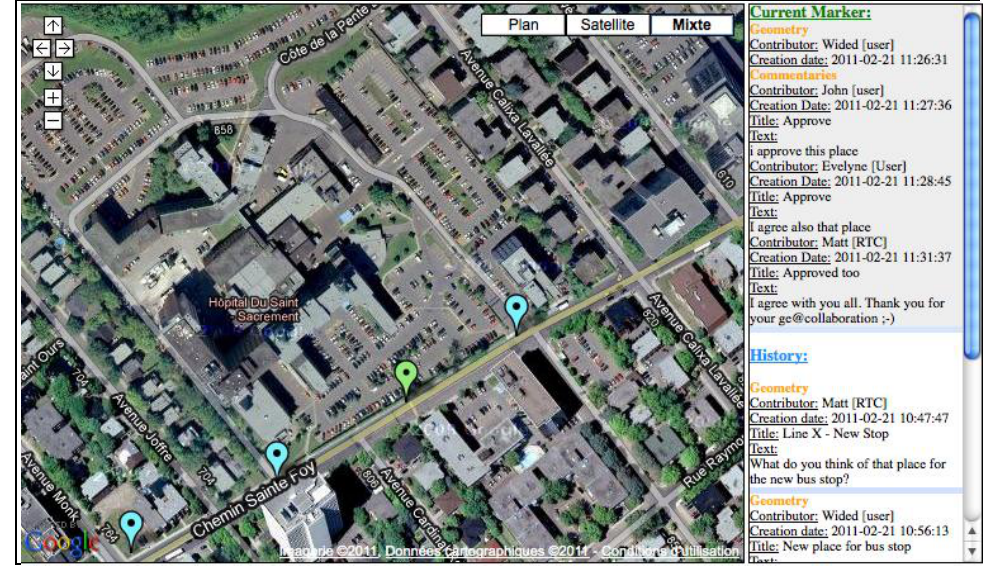
Figure 12. Visualization of the different positions of the point, with its associated comments.